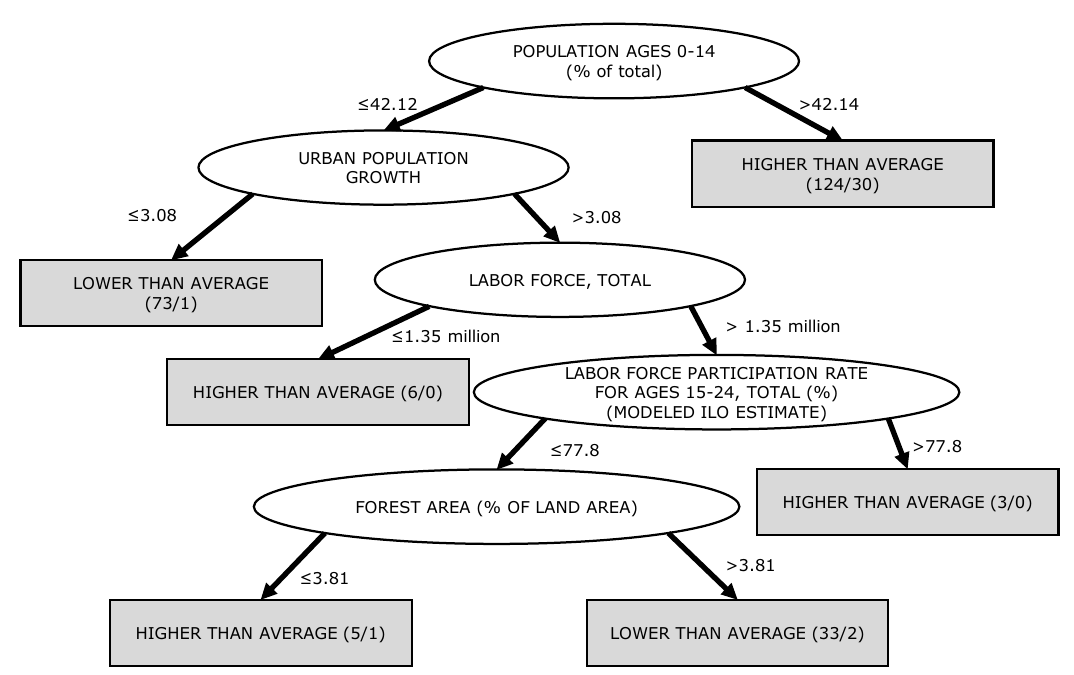
Figure A1. The model found with J48 for a timestep of 5 years.